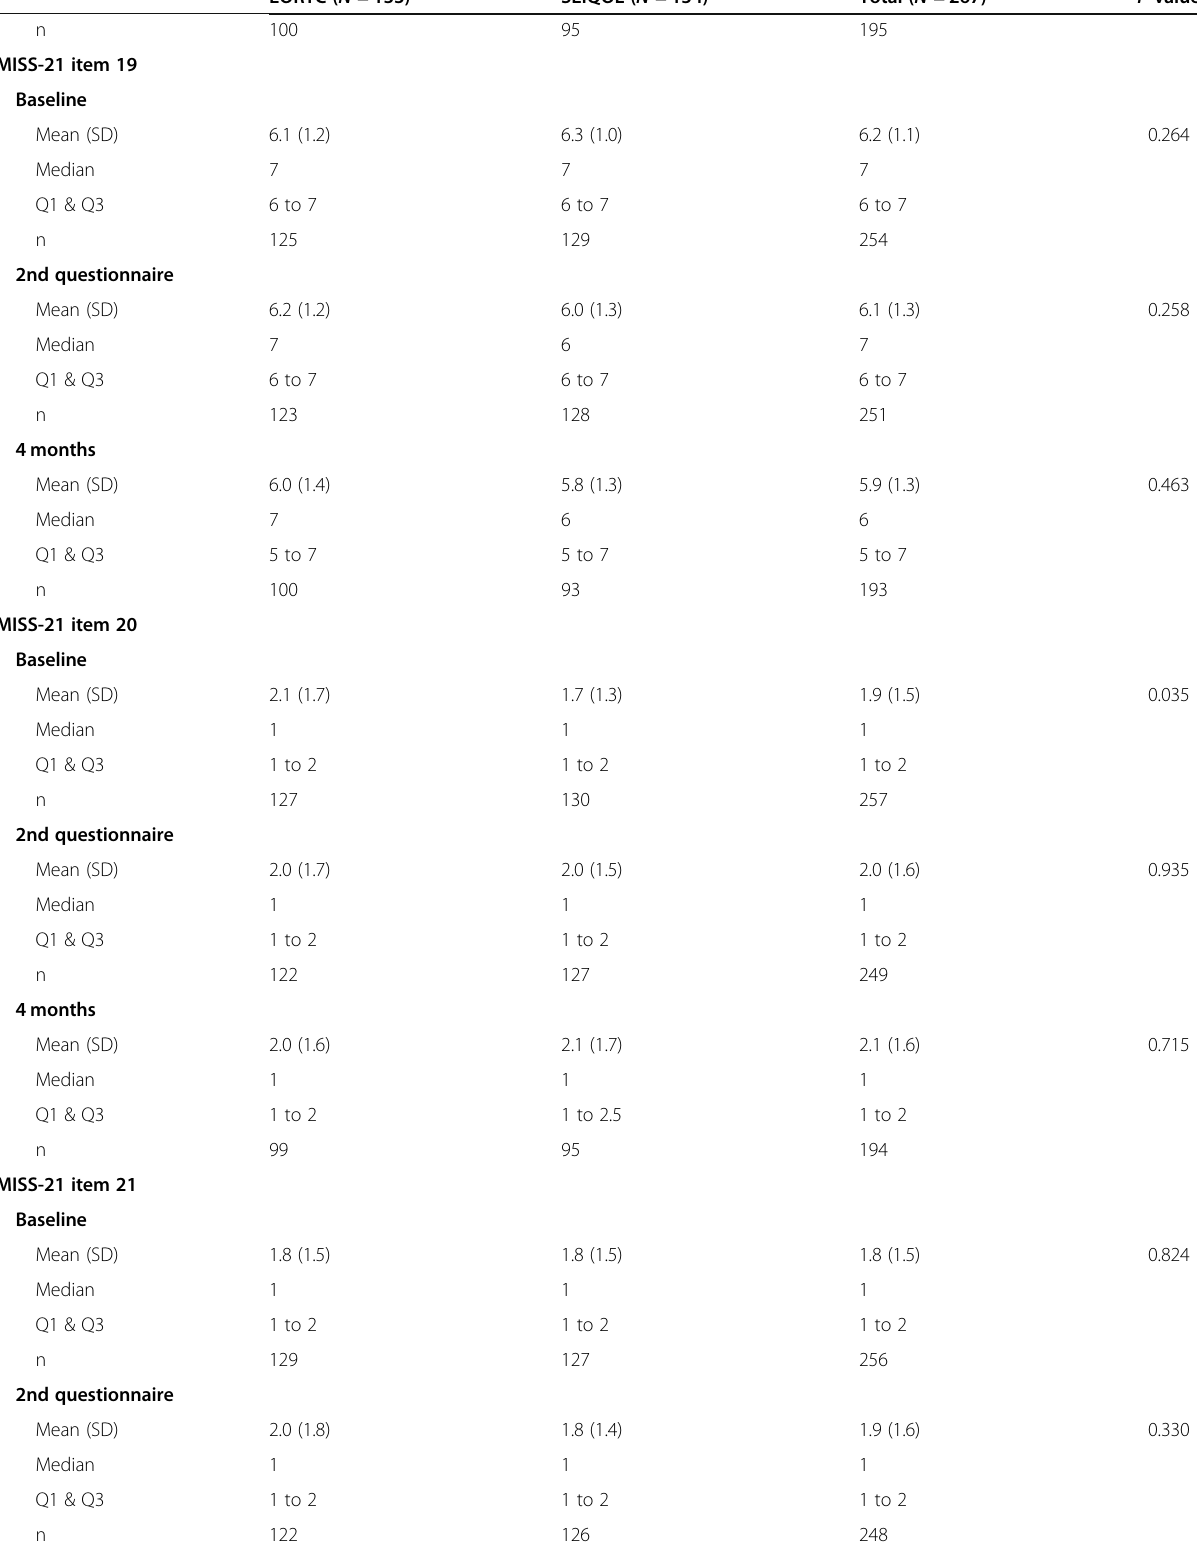
Table 2 Outcomes a over time for analyzed patients